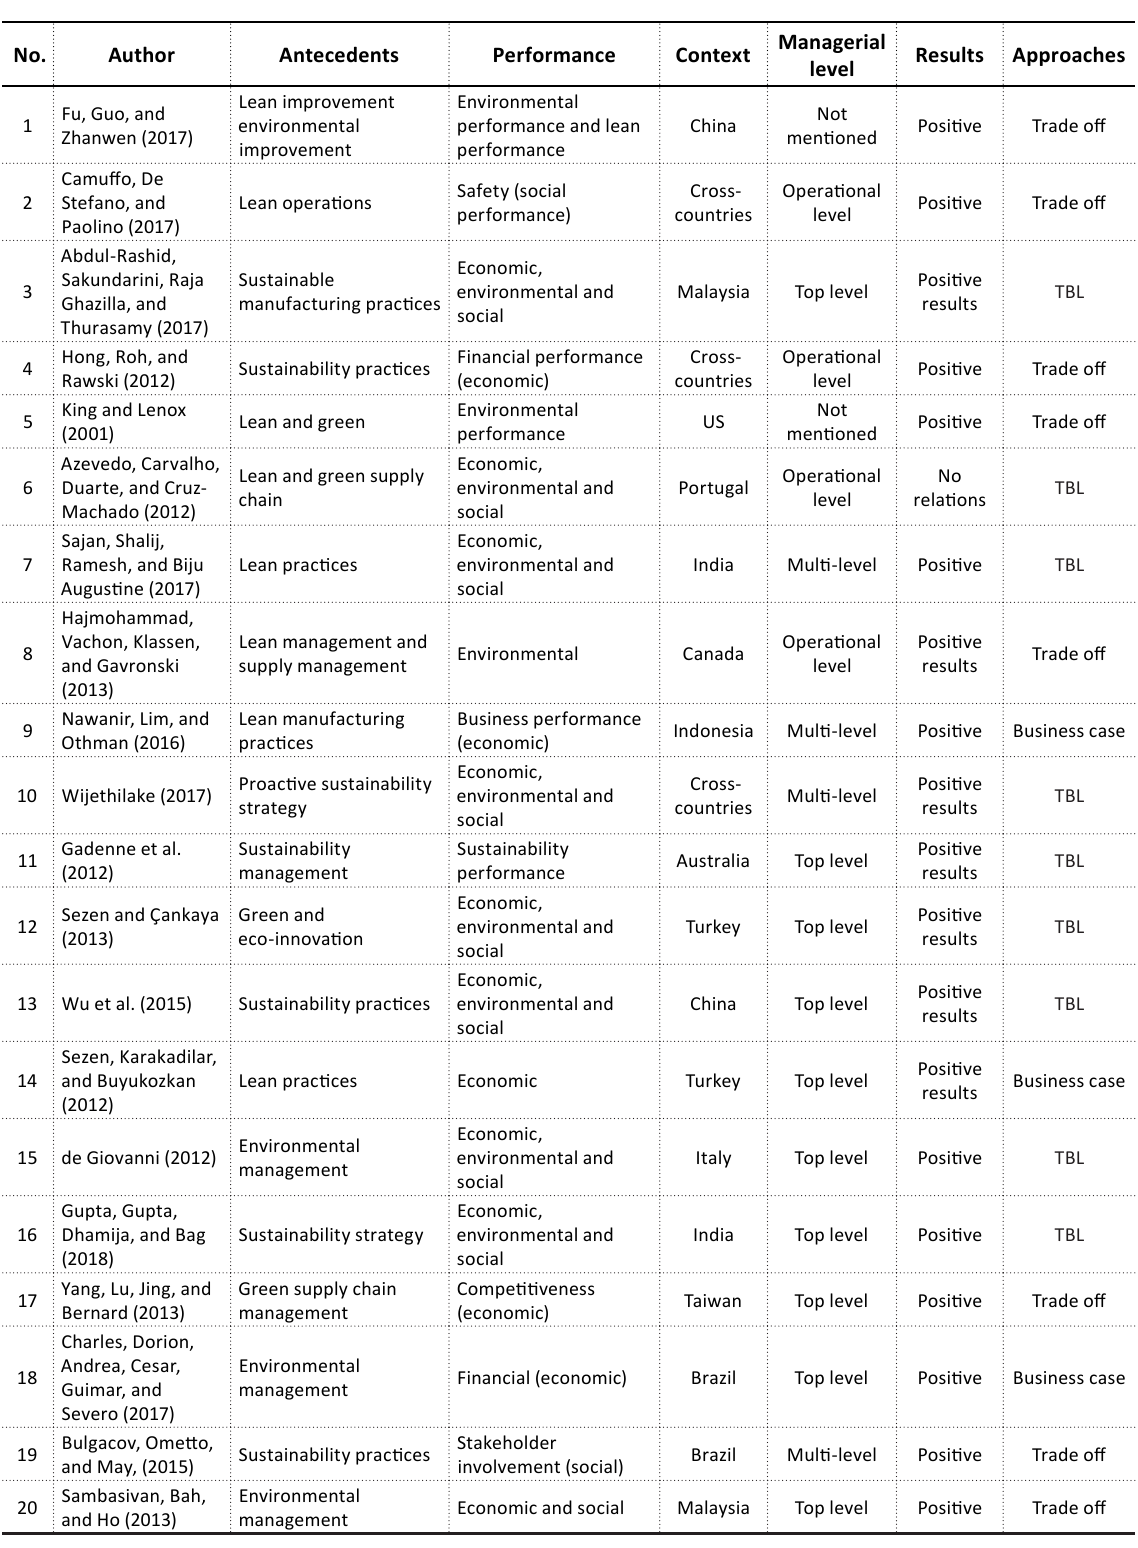
Table A1. The description of sustainability performance, antecedents, approaches, country context and managerial